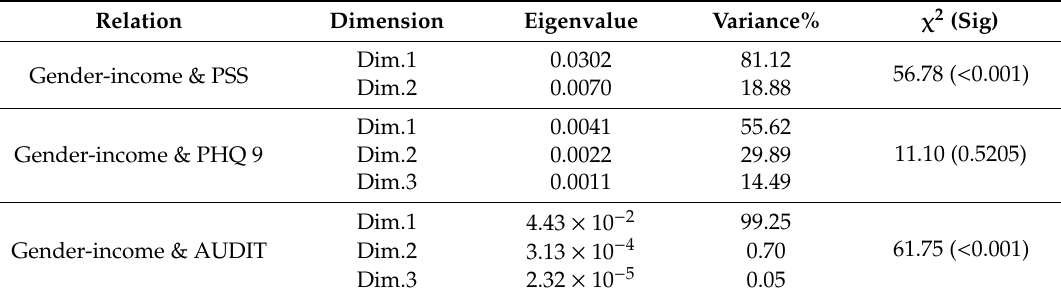
Table 5. Correspondence analysis output.